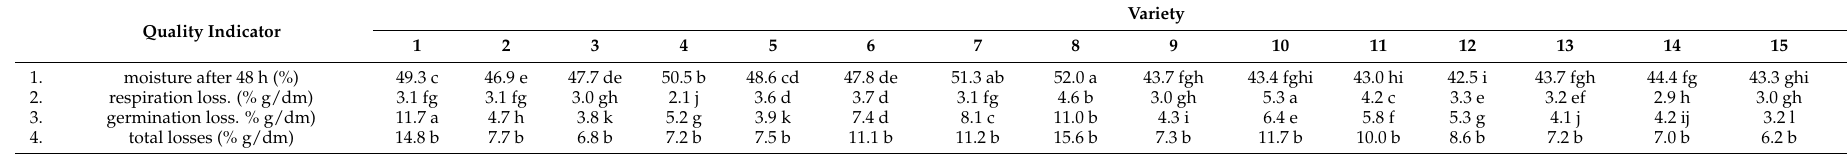
Table 6. Results of micromalting analysis (procedure D).